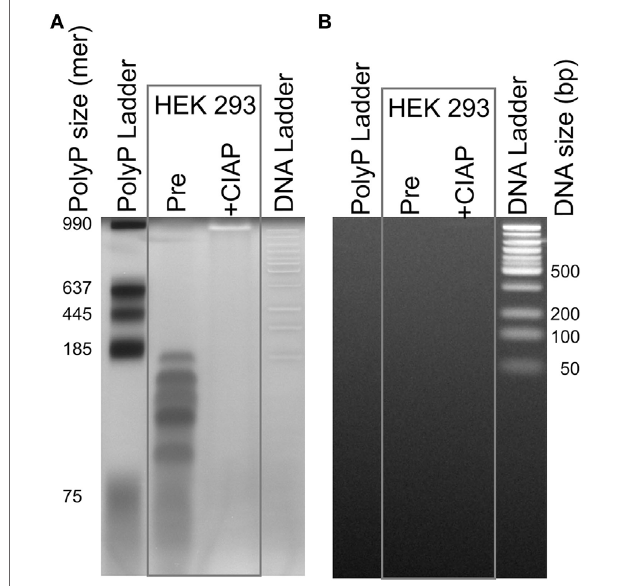
FigUre 3 | Traces of polyphosphate (polyP) in cell-derived DNA. DNA isolated from HEK 293 cells using the DNeasy Blood & Tissue kit was extensively digested with benzonase to hydrolyze the DNA, concentrated, and then resolved by electrophoresis on a 4–20% polyacrylamide gel. Samples were: a locally prepared polyP ladder (lengths indicated in phosphate units); DNA purified from HEK 293 cells and digested with benzonase (“Pre”); the same material following digestion with calf intestinal alkaline phosphatase (CIAP); and 50 bp DNA ladder. The same gel was stained sequentially, using: (a) DAPI with extended photobleaching to detect polyP (27) and (B) SYBR Green I to detect DNA (after removing DAPI by repeated rinsing). The material in the lane marked “Pre” is clearly polyP as it photobleached rapidly (a) , was digested by CIAP (a) , and did not stain with SYBR Green 1 (B)